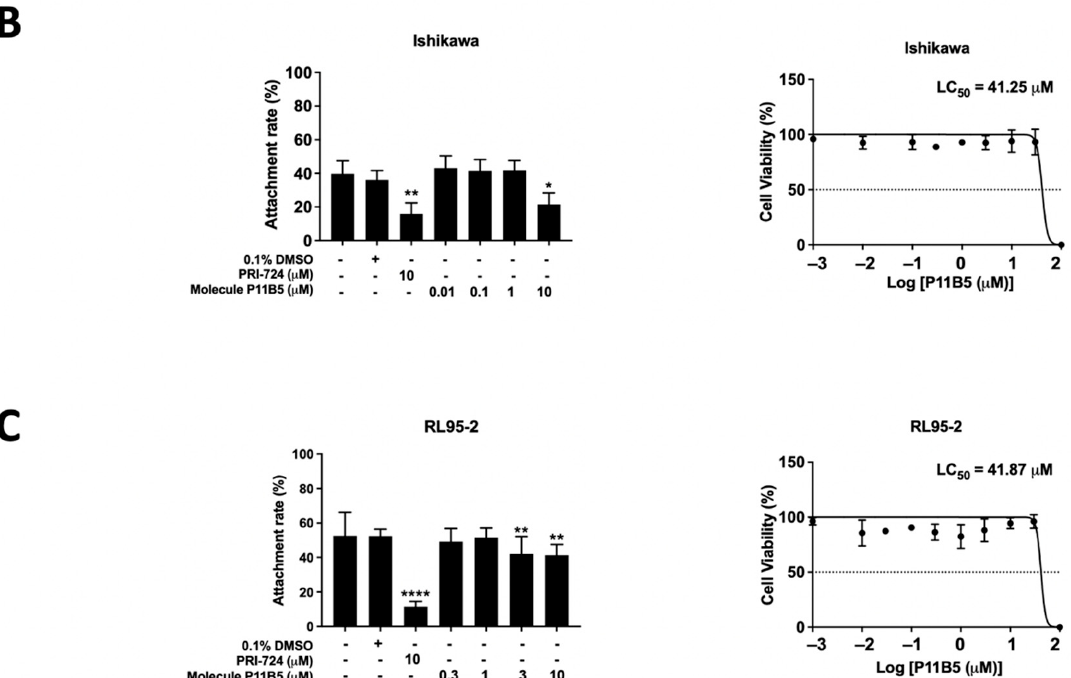
Figure 2. Cell viability assay in selected LOPAC and high-throughput attachment assay in Nemadipine-A (P11B5). ( A ) Ishikawa cells were treated with or without different concentrations (0.01, 0.1, 1, 10, and 100 µ M) of the selected LOPAC for 24 h. Cell viability was determined by XTT assay and values were compared to vehicle control (0.1% DMSO) and represented as percentages (n = 3). The spheroid attachment in the established high-throughput co-culture model and cytotoxic effects of Nemadipine-A (P11B5, 0.01–100 µM) were determined in human receptive endometrial epithelial, ( B ) Ishikawa, and ( C ) RL95-2 cells. *, **, and **** denote p < 0.05, <0.01, and <0.0001 in the Mann–Whitney U test or Kruskal–Wallis test followed by Dunn’s multiple comparisons test compared to medium or 0.1% DMSO control. PRI-724 at 10 µ M was used as a positive control in the co-culture